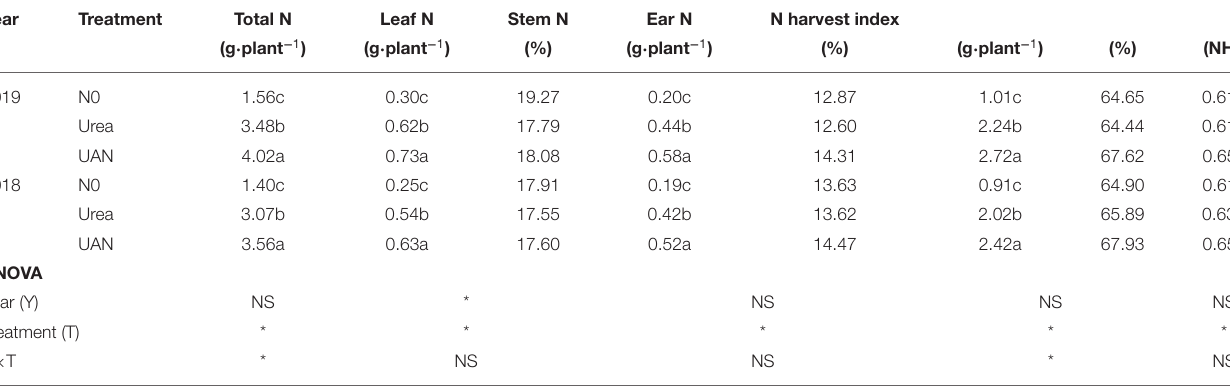
TABLE 3 | Effects of nitrogen fertilizer types on nitrogen accumulation and distribution of summer maize.